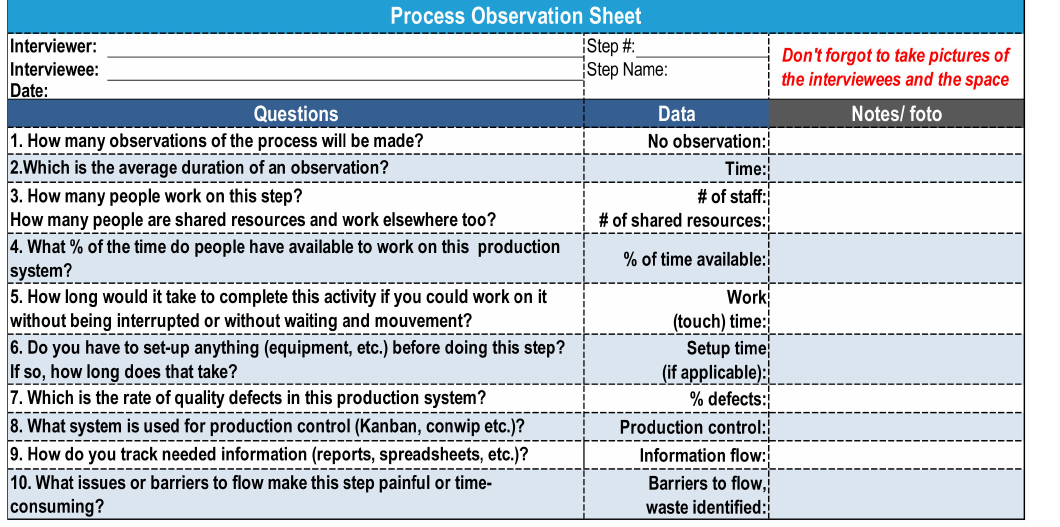
Figure 5. Questionnaire for processes observation.